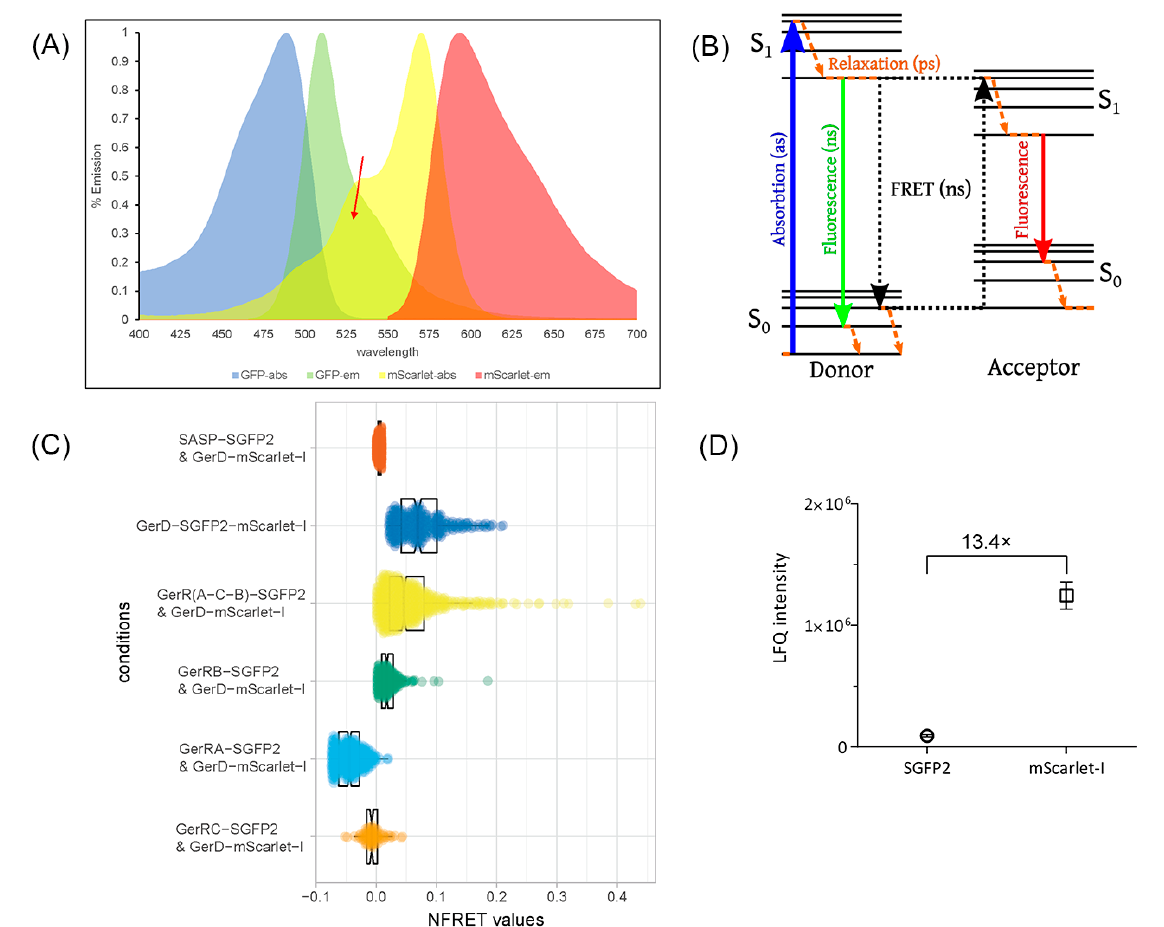
Figure 6. Analysis of interactions between IM proteins of the gerR operon and GerD by FRET. ( A ) The spectra of donor SGFP2 and acceptor mScarlet-I are shown. The specific wavelengths for excitation and emission are given in Table 2, in Materials and Methods. The red arrow indicates the spectral overlap between donor emission and acceptor excitation. ( B ) The FRET process is demonstrated in this Jablonski diagram (https://commons.wikimedia.org/w/index.php?curid=23197114, accessed on 30 June 2021). ( C ) Boxplots showing NFRET values in single spores of B. cereus strains F13 (SASP–SGFP2 and GerD–mScarlet-I), F11 (GerD–SGFP2–mScarlet-I), F06 (GerRB–SGFP2 and GerD–mScarlet-I), F09 (GerR(A-C-B)–SGFP2 and GerD–mScarlet-I), F07 (GerRA–SGFP2 and GerD–mScarlet-I), and F08 (GerRC–SGFP2 and GerD–mScarlet-I). The notches represent the 95% confidence interval for each median (data are given in Supplementary Materials Table S1). ( D ) Relative expression levels of SGFP2 and mScarlet-I in dormant spores of B. cereus strain F06 determined by mass spectrometry. The LFQ (label-free quantitation) intensity of SGFP2 and mScarlet-I indicated that the expression level of GerD was 13.4 times higher than each GerR protein. The sample processing, extraction of peptide material, and LC–FT–MS analysis were performed as described previously